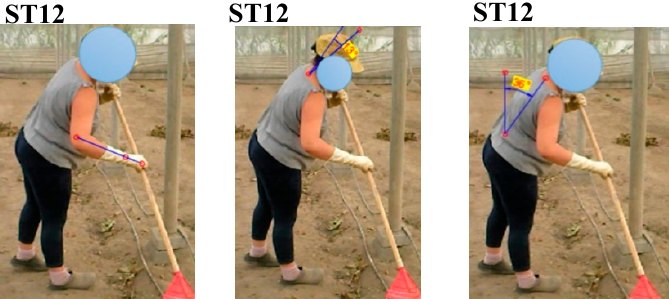
Figure A1. Measurements. Tasks corresponding to the codes indicated in Figure A1; ST1: (Making holes); ST2: (Planting); ST3: (Manual treatment); ST4: (Tractor treatment); ST5: (Leaf removal); ST6: (Melon cutting); ST7: (Melon harvesting (way 1)); ST8: (Melon harvesting (way 2)); ST9: (Transporting containers); ST10: (Plant removal); ST11: (Greenhouse plant removal); ST12: (Greenhouse sweeping).